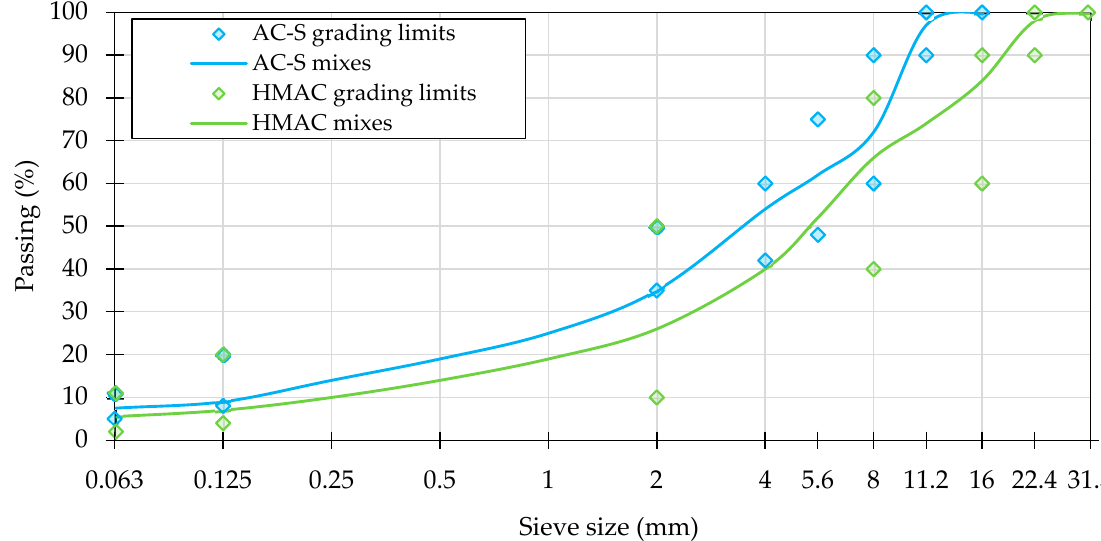
Figure 1. Grain size distribution in the investigated asphalt mixtures.